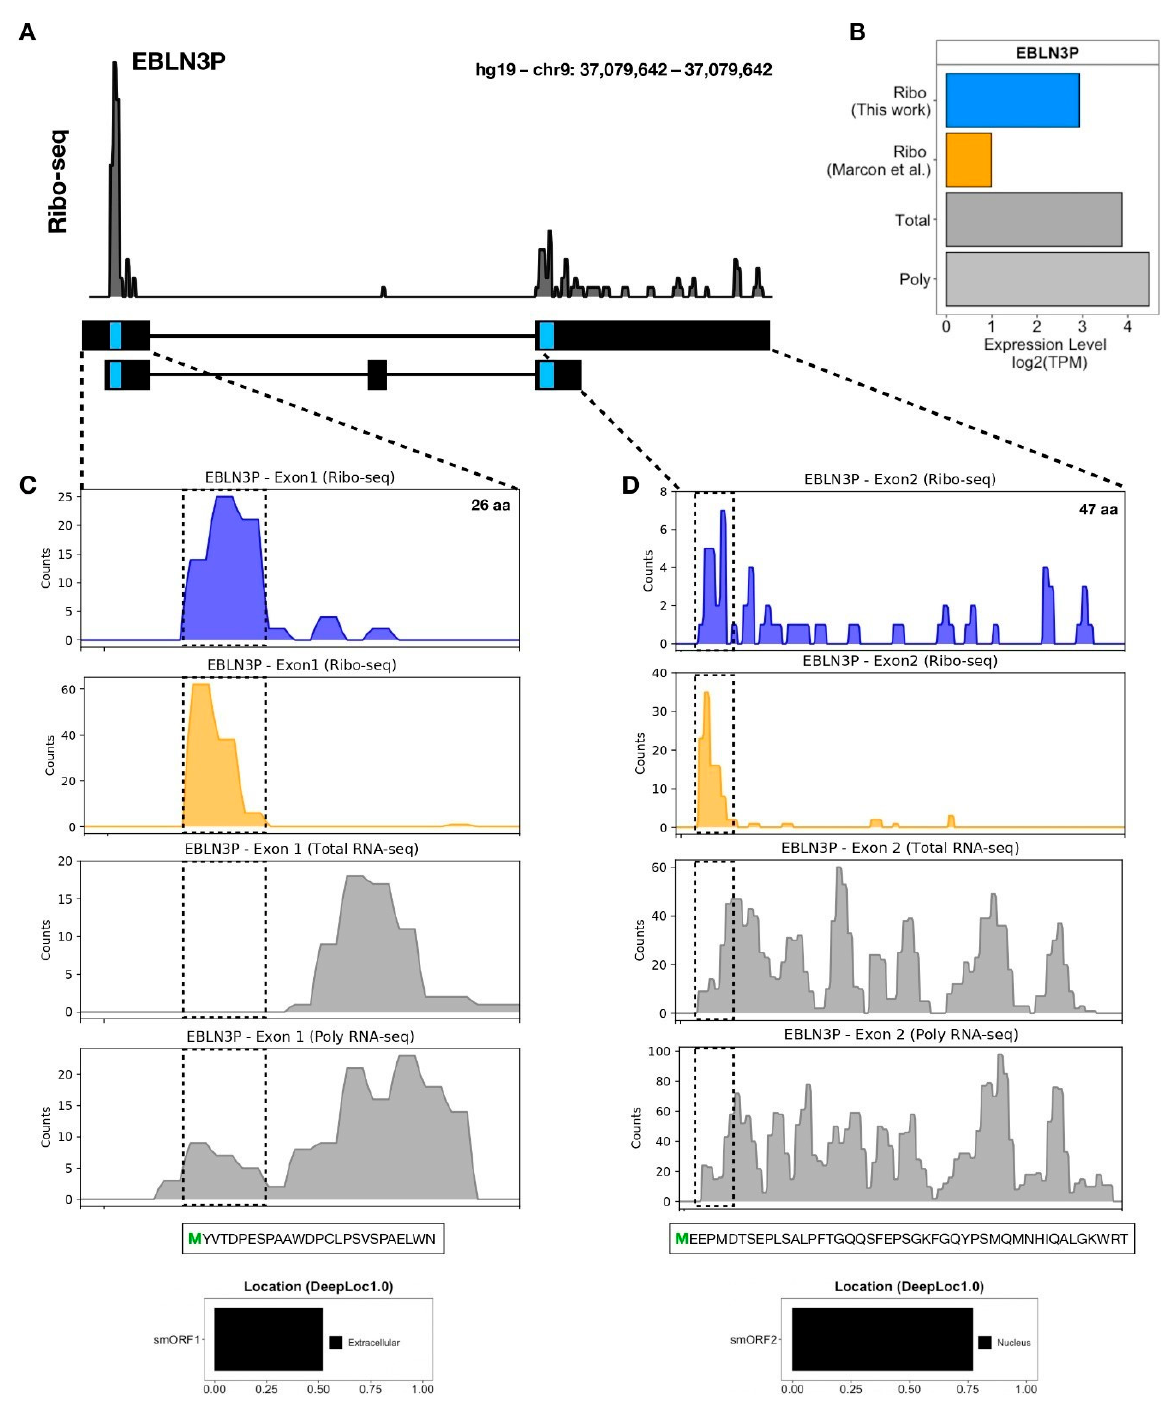
Figure 4. Putative smORFs-derived microproteins within EBLN3P lncRNA in hASC. ( A , B ) Ribosome coverage and the expression level of EBLN3P in different datasets, respectively. ( C ) Ribosome occupancy of smORFs located in exon 1 of EBLN3P, showing a putative 26-aa microprotein with extracellular localization prediction. ( D ) Ribosome occupancy of smORFs located in exon 2 or 3 of EBLN3P, showing a putative 47-aa microprotein with nuclear localization prediction. The upper panel represents Ribo-seq coverage from this study, the second panel represents Ribo-seq coverage from Marcon et al., the third panel represents Total RNA-seq coverage, and the lower panel represents Polysomal RNA-seq coverage; the y-axis represents transcript raw counts. Light blue boxes indicate the smORF location in transcripts, and the dashed boxes represent the smORF location in the read coverage